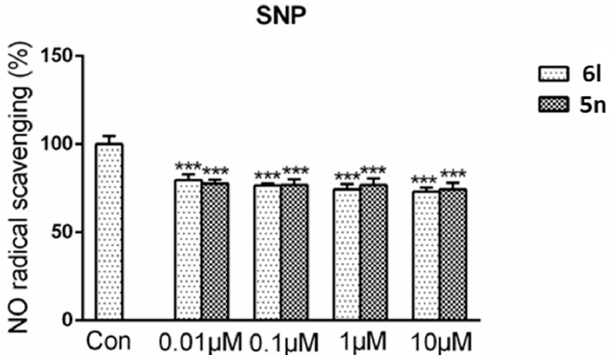
Figure 3. Compound 6l and 5n had NO radical scavenging activity. 6l (0.01 µ M, 0.1 µ M, 1 µ M, and 10 µ M) or 5n (0.01 µ M, 0.1 µ M, 1 µ M, and 10 µ M) was added to a concentration of 0.5 mM